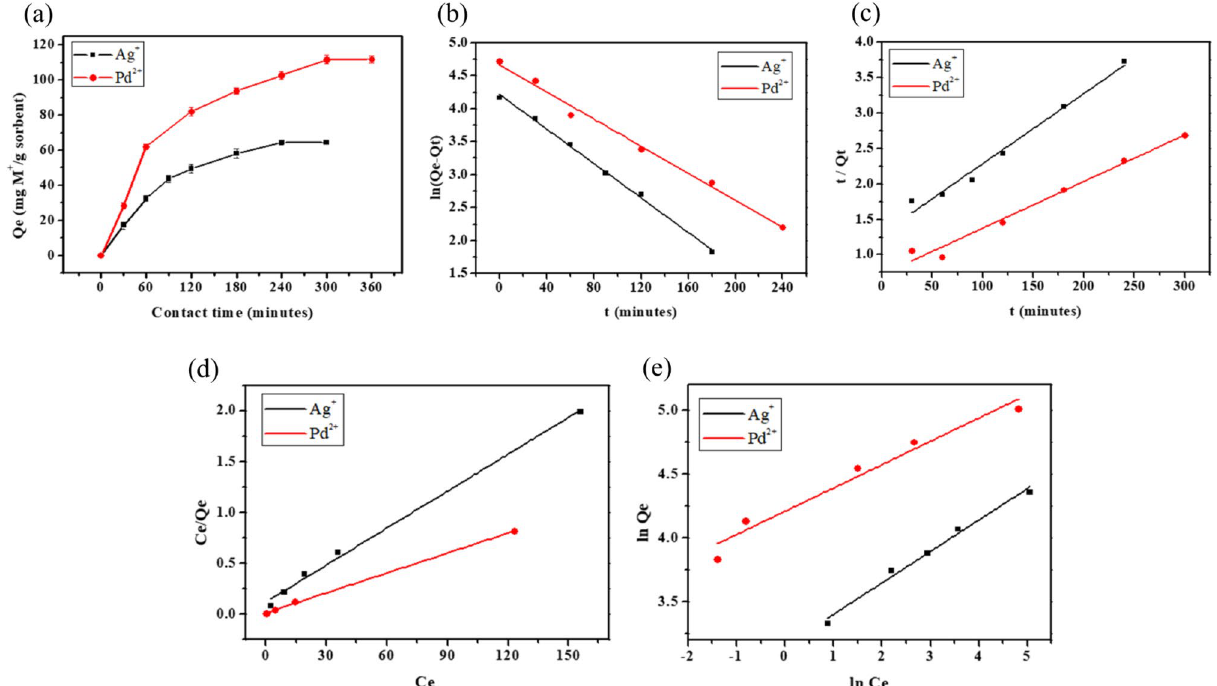
Figure 3. The adsorption behavior of Ag(I) and Pd(II) using ATU-PEGDA. ( a ) Contact time; ( b ) fitting results of pseudo-first-order kinetic model; ( c ) fitting results of pseudo-second-order kinetic model; ( d ) fitting results for the Langmuir; ( e ) fitting results fro the Freundlich